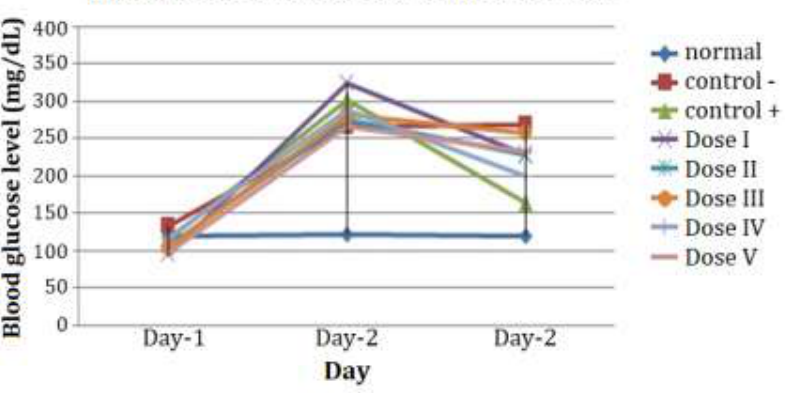
Figure 2. Average blood glucose level before and after treatment microcapsules of aqueous fraction C.